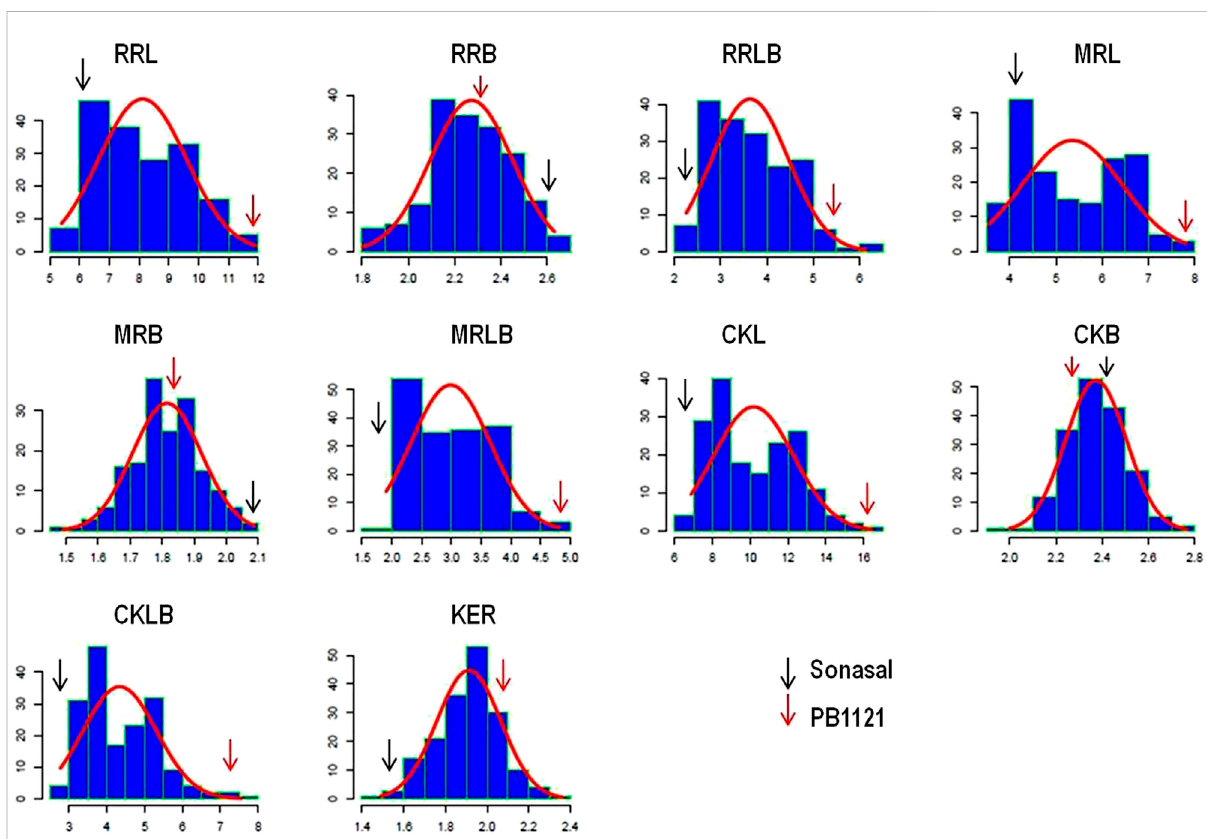
FIGURE 2 DistributionpatternofgraindimensiontraitsinanRILpopulation.roughricelength(RRL),roughricebreadth(RRB),roughricelengthtobreadth ratio(RRLB),milledricelength(MRL),milledricebreadth(MRB),milledricelengthtobreadthratio(MRLB),cookedkernellength(CKL),cookedkernel breadth (CKB), cooked kernel length to breadth ratio (CKLB), and kernel elongation ratio